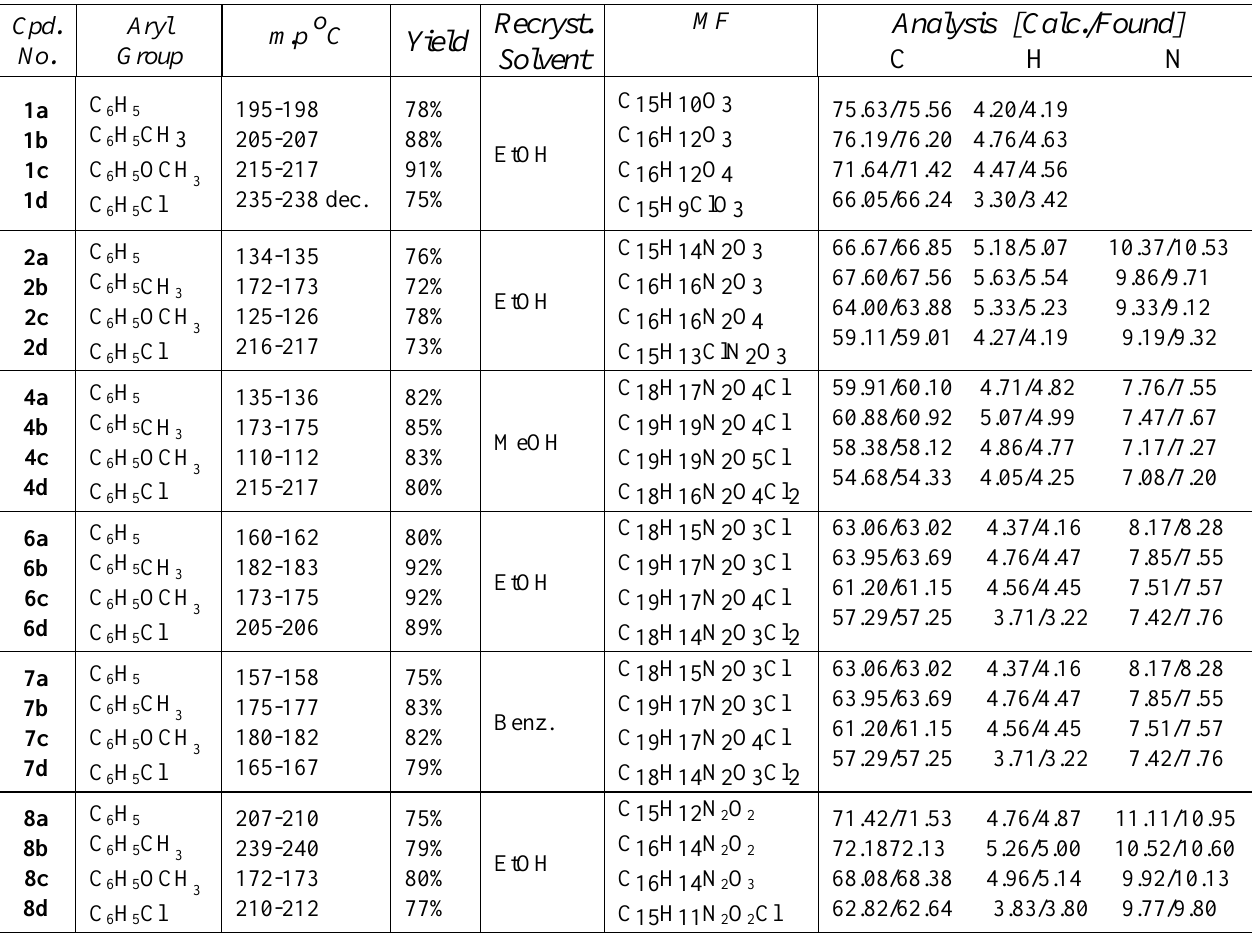
Table 2. Physical data for compounds 1a - 8d .